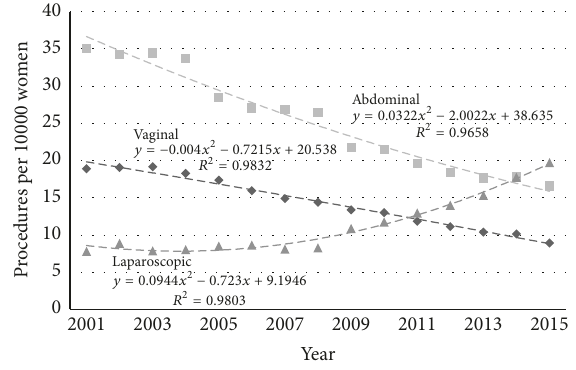
Figure 7: Percentage of procedures involving removal of the adnexae by route of hysterectomy ( X vaginal, ◼ abdominal, and 󳵳 laparoscopic) in Australia for women aged 55–74 years. The epoch in which guidance advised opportunistic salpingectomy is shaded.